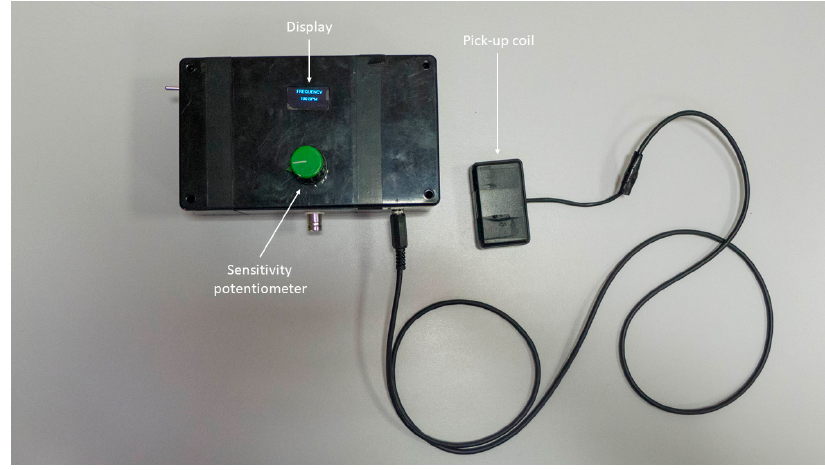
Figure 10. The assembled prototype of the sensor.